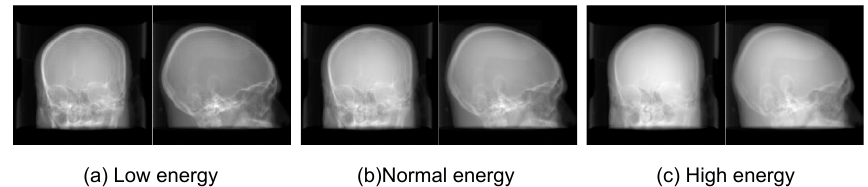
Figure 11. Examples of CT-DRR datasets in different X-ray energies.